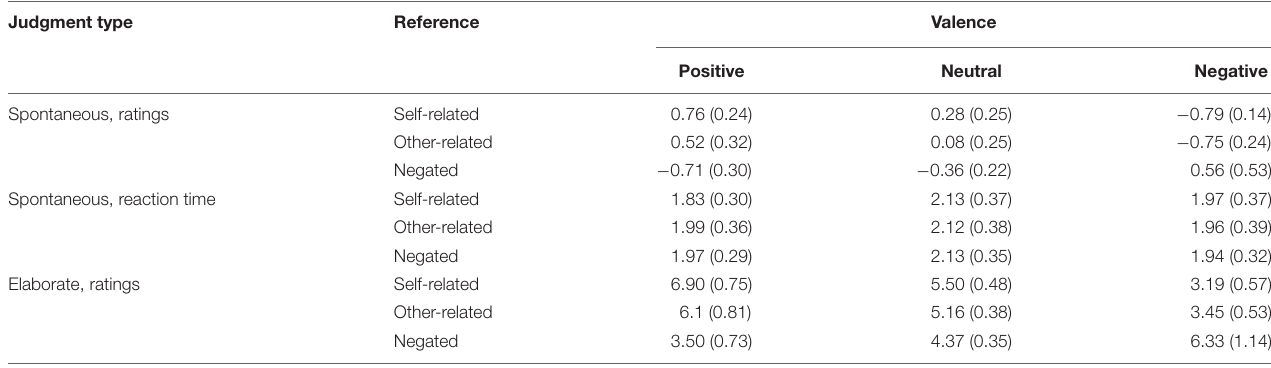
TABLE 3 | Descriptive statistics of spontaneous and elaborate valence judgments ( N = 29).